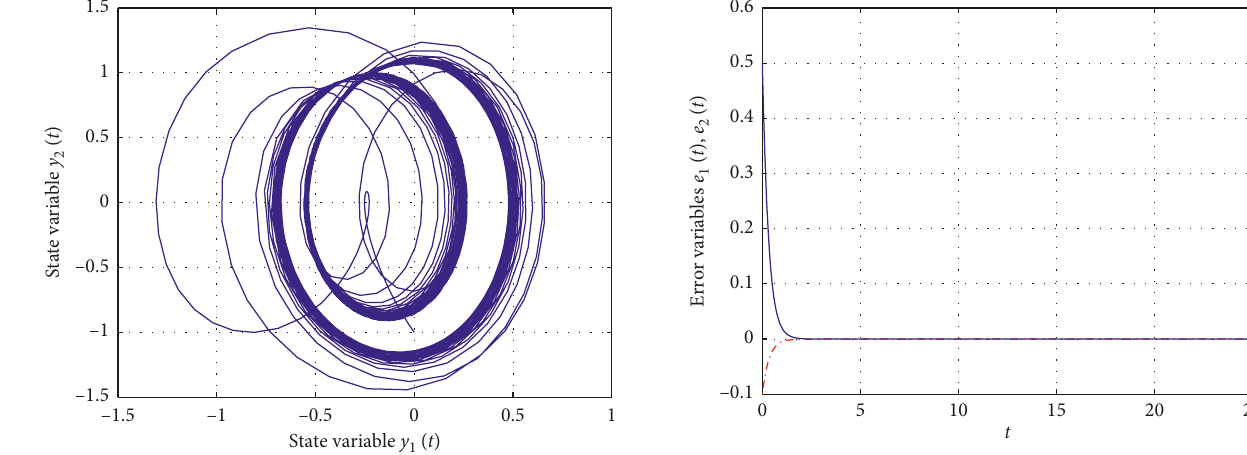
Figure 1: The phase diagram of the chaotic Φ 6 Duffing oscillator.